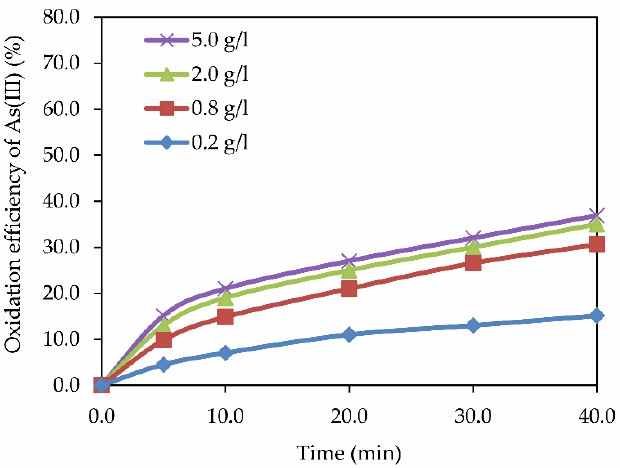
Figure 2. As (III) oxidation efficiency as a function of Fe (II) ion concentration.